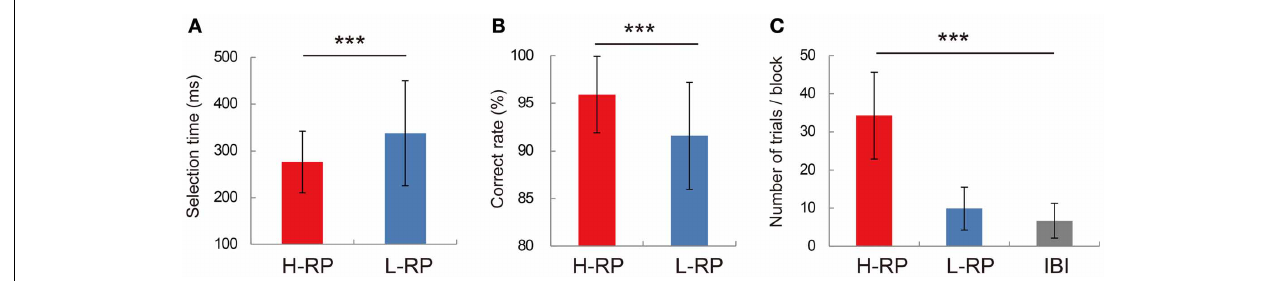
FIGURE 2 | Behavioral performance in recording sessions. (A) Mean selection times under the H-RP and L-RP conditions in all sessions. Error bars show standard deviations. (B) Mean correct rates under the H-RP and L-RP